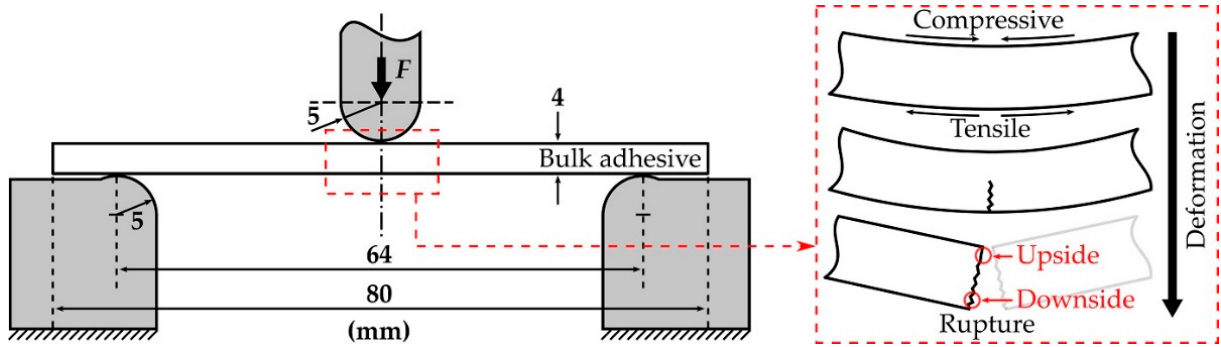
Figure 6. Schematic illustration of the three-point flexural test ( left ) and bulk adhesive specimen deformation and rupture ( right ).